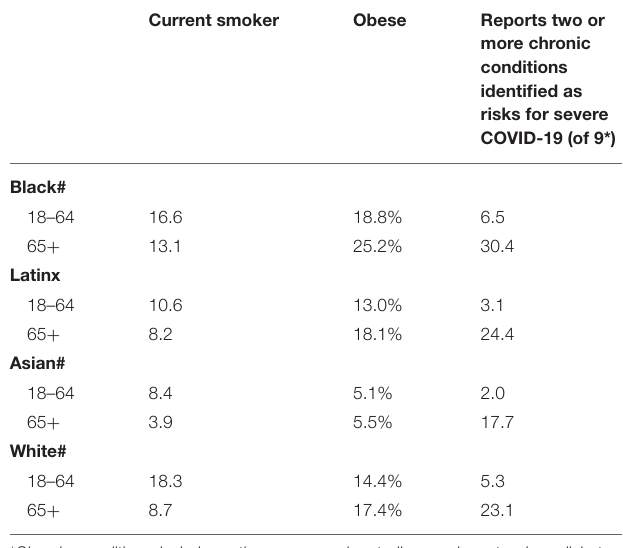
TABLE 5 | Risk factors for severe COVID-19, US